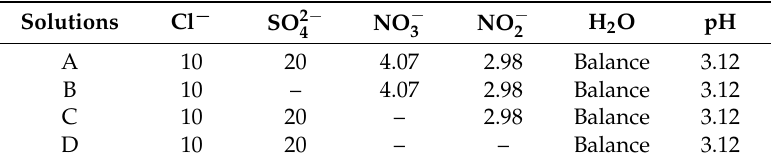
Table 2. Chemical compositions of four solutions